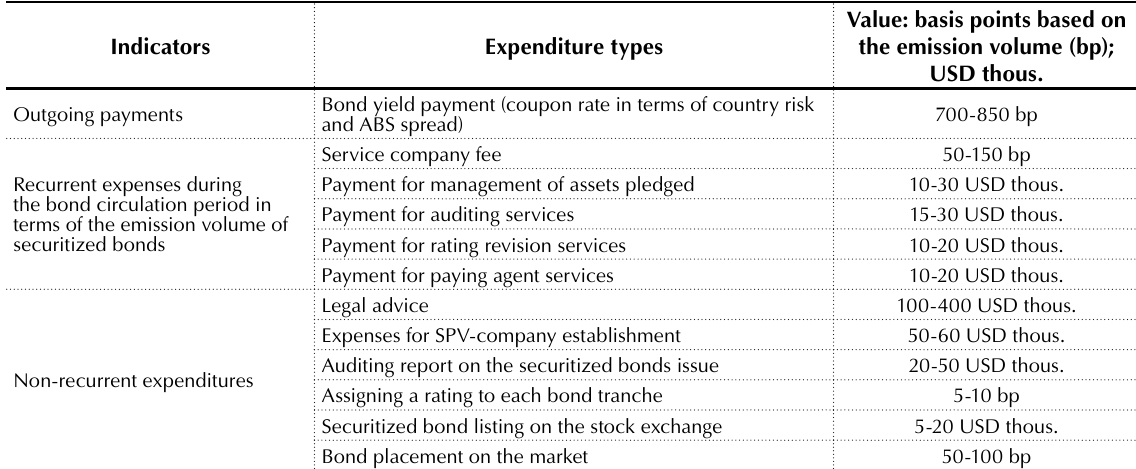
Table 2. Calculated expenditure structure for issuance of corporate securitized bonds in Ukraine (in terms of bond issuance equal to USD 50